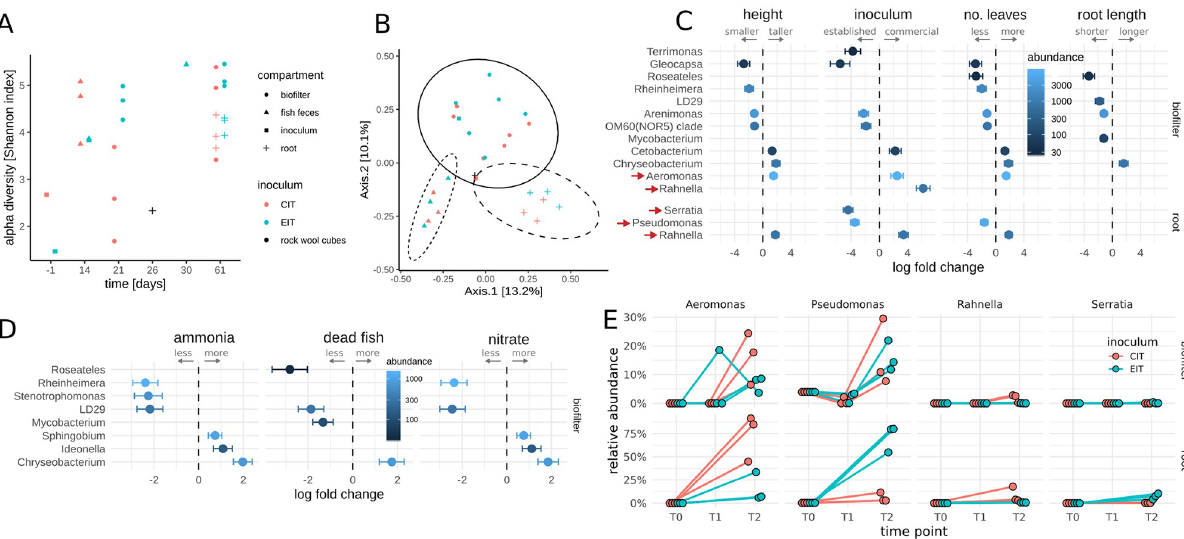
Fig 3. Amplicon sequencing of the full-length 16S rRNA gene across the aquaponic systems. (A) Alpha-diversity (Shannon index) over time. Colors and shapes denote initial microbial sources and sampling compartments respectively. All samples were rarefied to 3,000 reads each. (B) PCoA plot of individual samples from all time points. Colors and shapes are the same as in panel A. All samples were rarefied to 3,000 reads each. Ellipses denote 95% confidence interval from Student t-distribution separating compartments. (C) Significant associations (FDR adjusted p < 0.05) between bacterial genera and plant growth metrics or inoculum. Points denote the association coefficient in the respective regression and error bars denote the standard error of the coefficient. Fill color denotes average abundance across all samples. (D) Significant associations (FDR adjusted p < 0.05) between bacterial genera and measures associated with nitrification. Circles denote the association coefficient in the respective regression and error bars denote the standard error of the coefficient. Fill color denotes average abundance across all samples. (E) Time course of selected genera associated with plant growth and inoculum. Time point zero is shared between all samples and denotes initial inoculum for biofilter and initial plant microbial composition for roots. Only genera with more than 300 reads in at least 2 samples were considered in A-E (see Materials and methods).